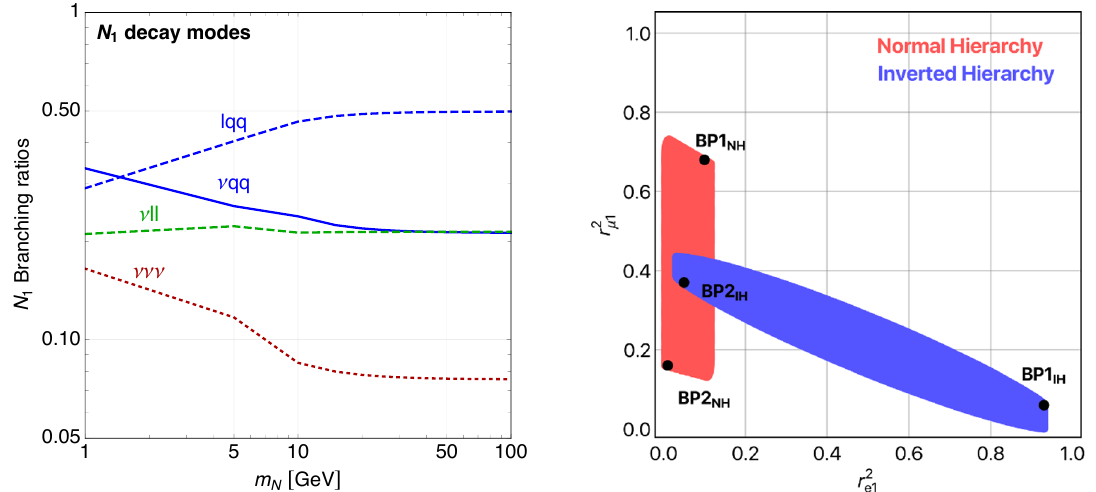
Figure 1 . Left: decay modes of the lightest RH neutrino N 1 . We have fixed δ = φ 1 = β = γ = 0 . Right: allowed ranges in the r 2 and φ in the range [0 , 2 π ] with r τ 1 = 1 − r 2 the